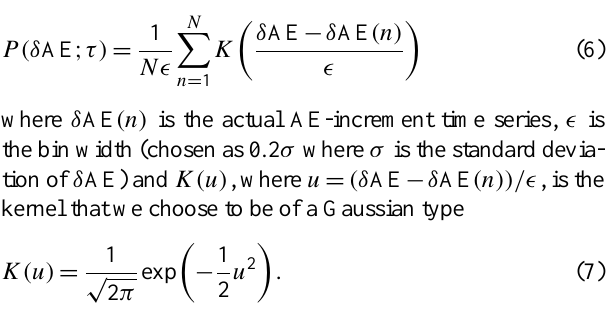
Fig. 2. The probability of return P (0; τ ) versus τ on a log-log plot. The dashed line is a power-law with exponent s ∼ 0 . 487 .